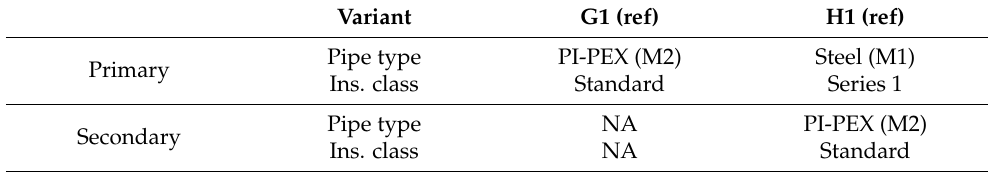
Table 4. Reference pipe type and insulation class for the GRUDIS and hybrid distribution concept.